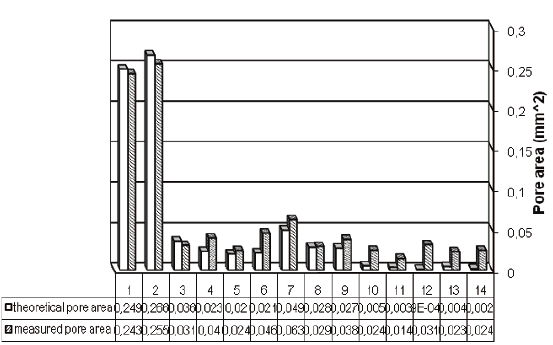
Figure 6. Comparison between measured and calculated pore area